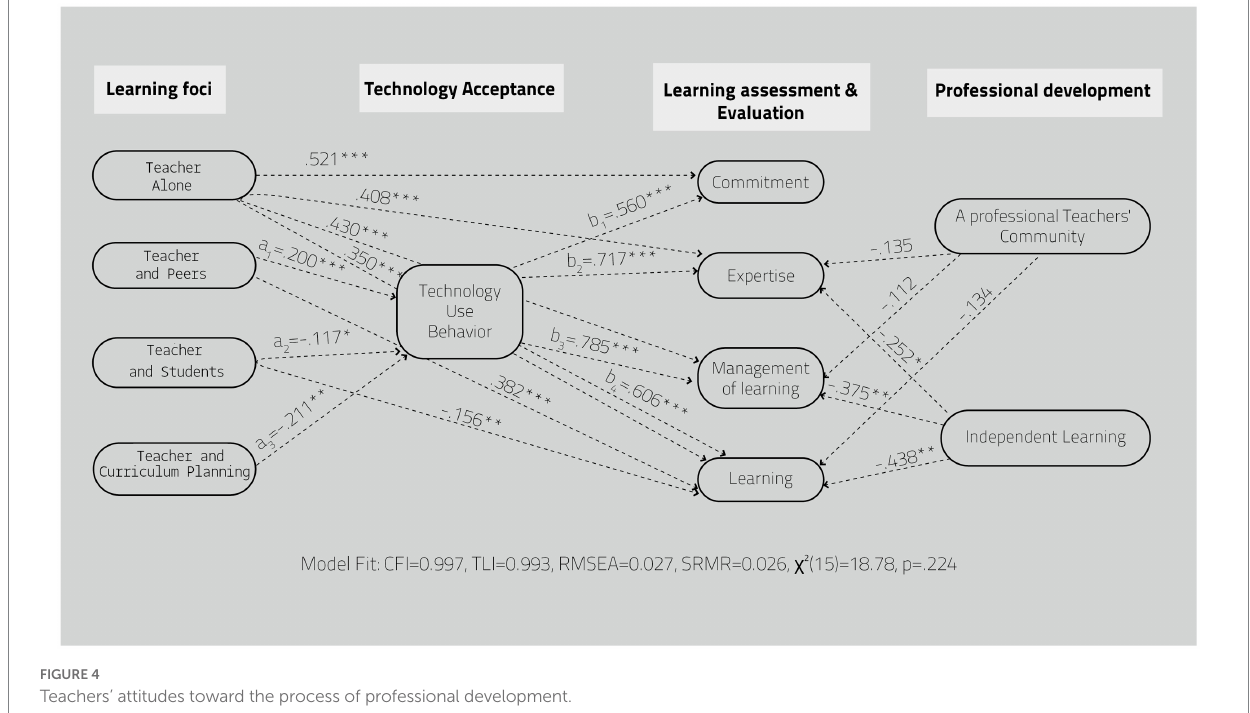
FIGURE 4 Teachers’ attitudes toward the process of professional development.